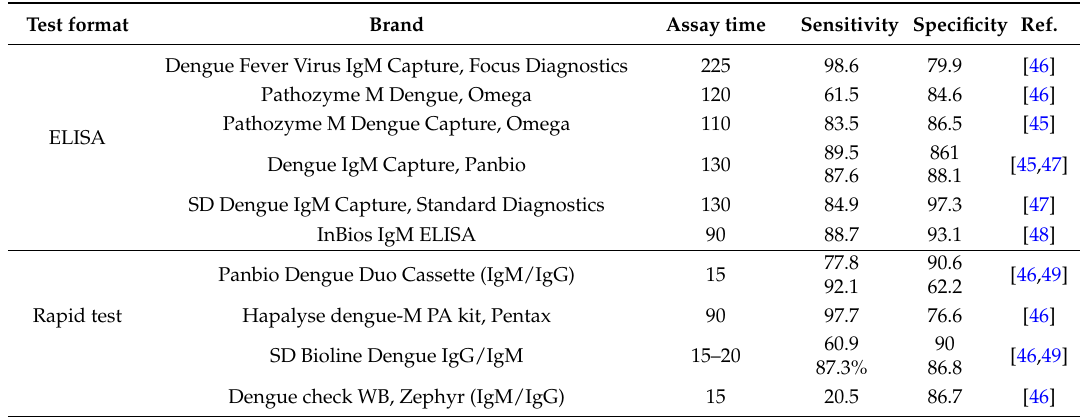
Table 2. Sensitivity and specificity of evaluated commercialized dengue specific IgM ELISA and rapid